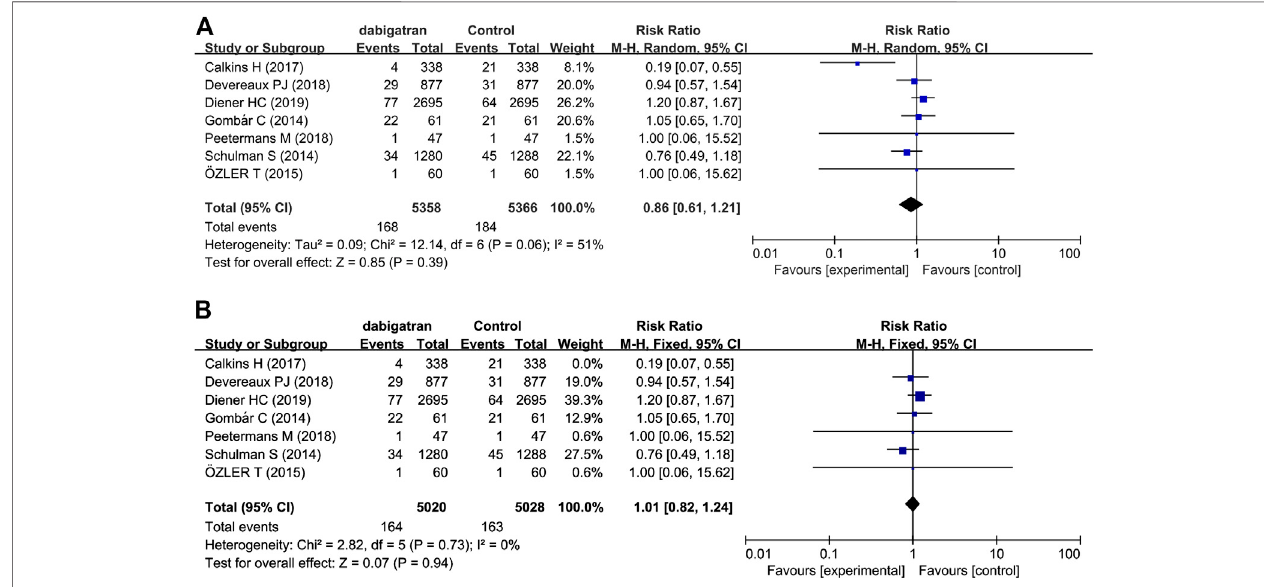
FIGURE 3 | Forest plot comparing the RR of major bleeding between the experimental (dabigatran) and control group (A) . Control group, conventional treatments with other medications; experimental group, conventional treatments with dabigatran. Forest plot after heterogeneity was deleted (B) .